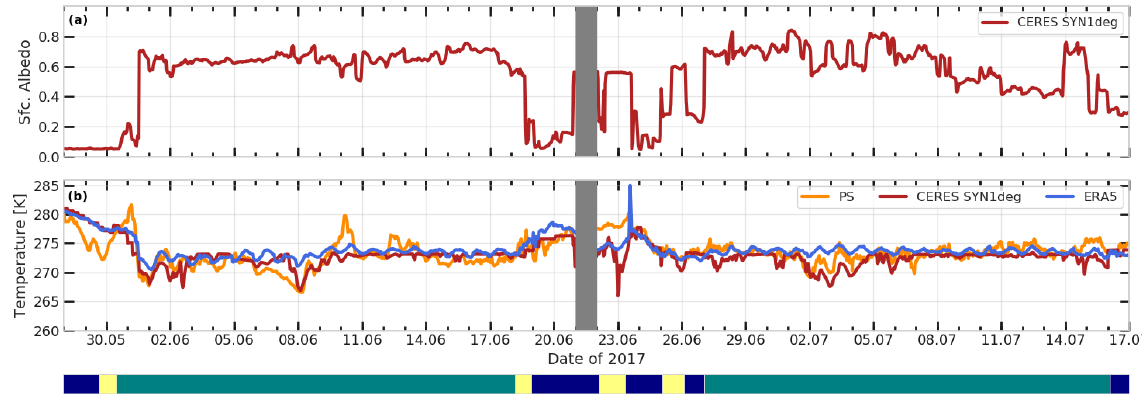
Figure 2. Time series of surface properties along the PS106 cruise track. Panel (a) shows the surface albedo based on CERES SYN1deg in red. Panel (b) shows the temperature based on Polarstern (PS) observations at 10ma.s.l. in orange, and the skin temperatures from ERA5 and CERES SYN1deg in blue and red, respectively. The lower coloured band indicates the times when Polarstern was located in open ocean (blue), the marginal sea-ice zone (yellow), and in mostly sea ice (teal). Table 1. Table indicating references and remote-sensing instrumentation used to derive cloud macro- and microphysical properties for CERES SYN1deg and Cloudnet data sets. Units are shown in